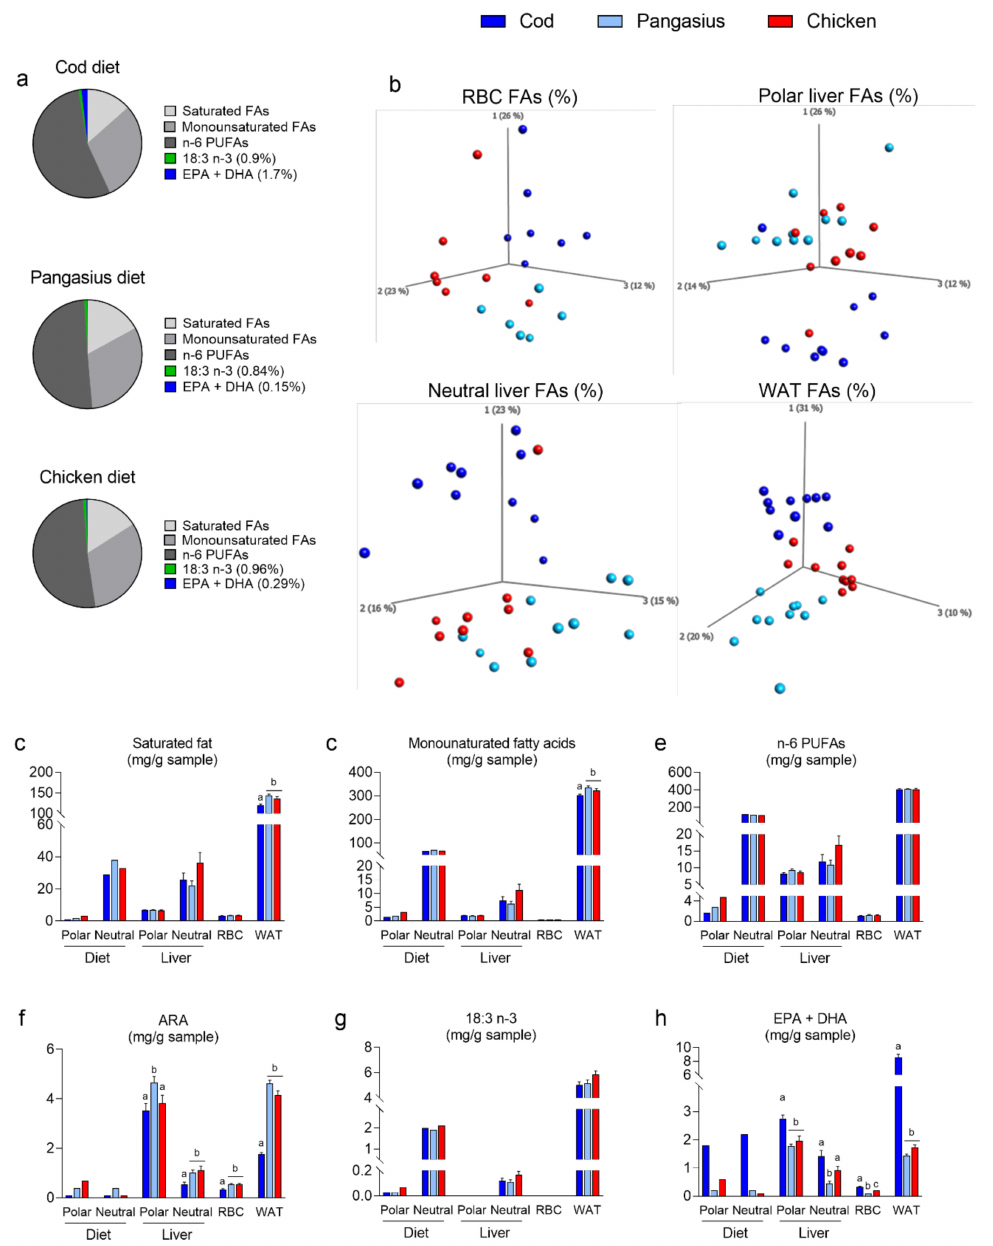
Figure 4. ( a ) Fatty acid composition of the HF / HP diets with cod, pangasius or chicken as the protein source. ( b – h ) Lipids from diets and livers were extracted and separated into polar and neutral lipid fractions. Fatty acid composition was measured and quantified in the fractions from diets, livers ( n = 10), in extracted lipids from red blood cells comprising mainly polar lipids (RBCs) ( n = 7) and in white adipose tissue (eWAT) comprising mainly neutral lipids (WAT) ( n = 10). ( b ) PCA plot of fatty acid composition (%) in RBCs, polar liver lipids, neutral liver lipids and eWAT. ( c ) Sum saturated fatty acids, ( d ) sum monounsaturated fatty acids, ( e ) sum n-6 fatty acids, ( f ) sum arachidonic acid (ARA, 20:4 n-6), ( g ) sum alpha-linolenic acid 18:3 (n-3) and ( h ) sum eicosapentaenoic acid (EPA, 20:5 n-3) + docosahexaenoic acid (DHA, 22:6 n-3). Data from livers, RBCs, and WAT are presented as the mean mg fatty acids / g sample ± SEM and analyzed using one-way ANOVA followed by Fisher’s LSD post hoc test. Di ff erent letters denote statistical significance ( p < 0.05) between the